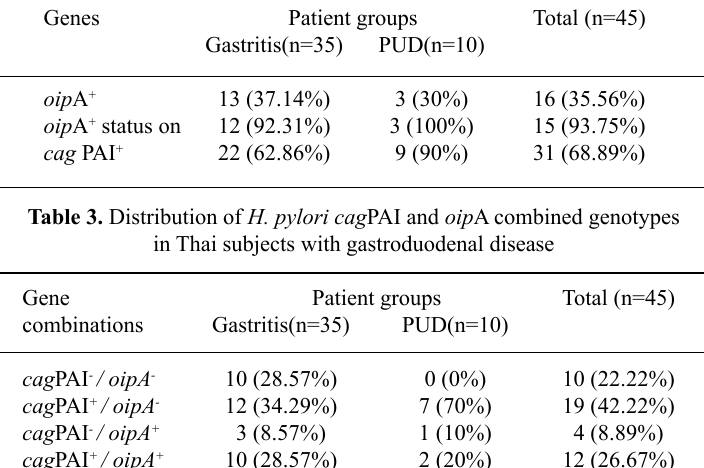
Table 2. The prevalence of oip A and cag PAI genes in Thai subjects